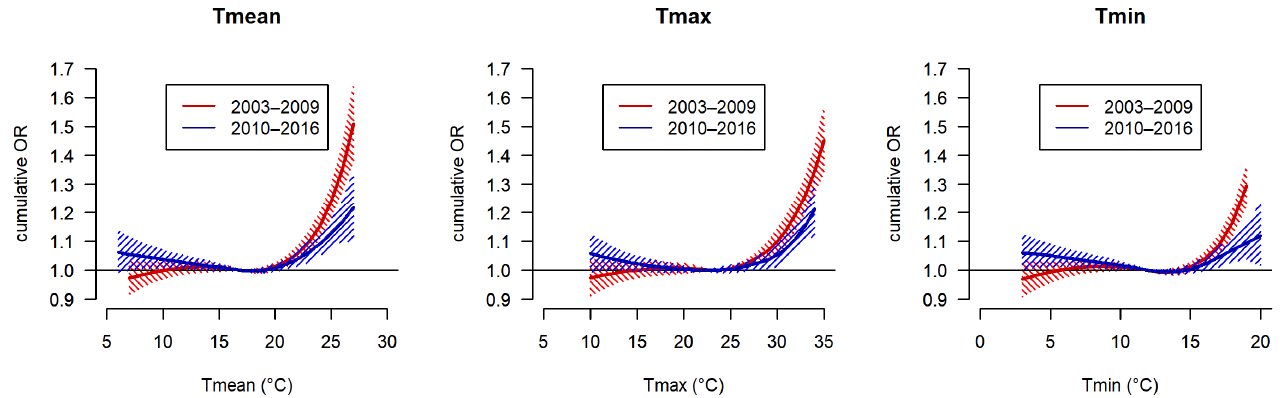
Figure 2. Odds ratios (ORs) of mortality associated with temperature in two time periods (2003– 2009 and 2010–2016). ORs with 95% confidence intervals are shown for warm season (May– September) daily mean (Tmean), daily maximum (Tmax), and daily minimum (Tmin) temperature.